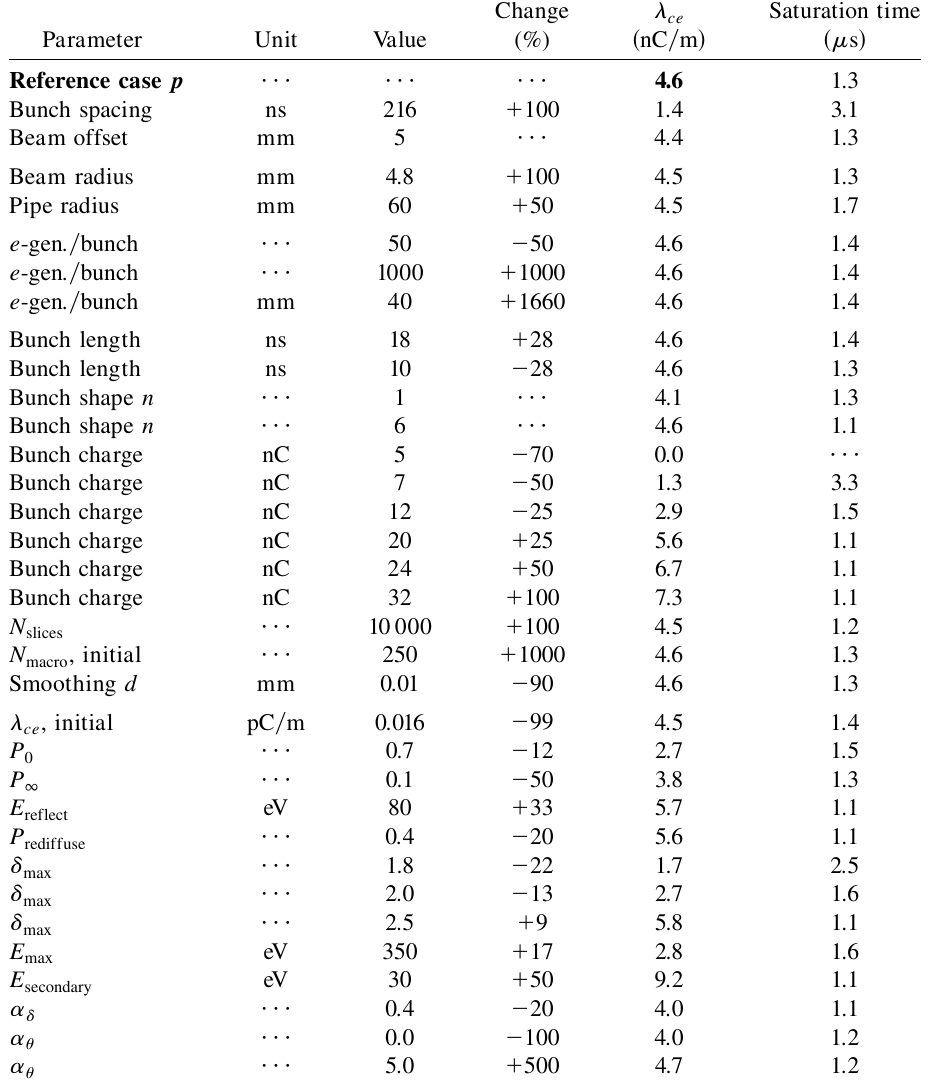
TABLE V. Maximum charge line density after 55 bunches and time after which saturation is reached in simulations under variation of input parameters. In each case only one parameter of the proton reference case is changed and the resulting line density is shown together with its relative